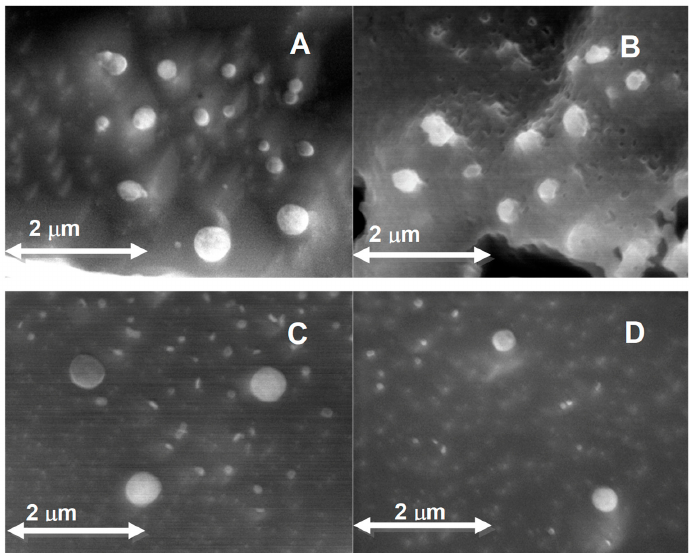
Figure 2. ( A ) Cryo-SEM images of liposomes formed by hydration of proliposomes produced by the SD method, without xanthone 2 at 50,000 × magnification; ( B ) Cryo-SEM images of liposomes formed by hydration of proliposomes produced by the SD method, with xanthone 2 at 50,000 × and 25,000 × magnification, respectively; ( C ) Cryo-SEM images of liposomes without xanthone 2 at 50,000 × magnification; and ( D ) Cryo-SEM images of liposomes with xanthone 2 at 10,000 ×